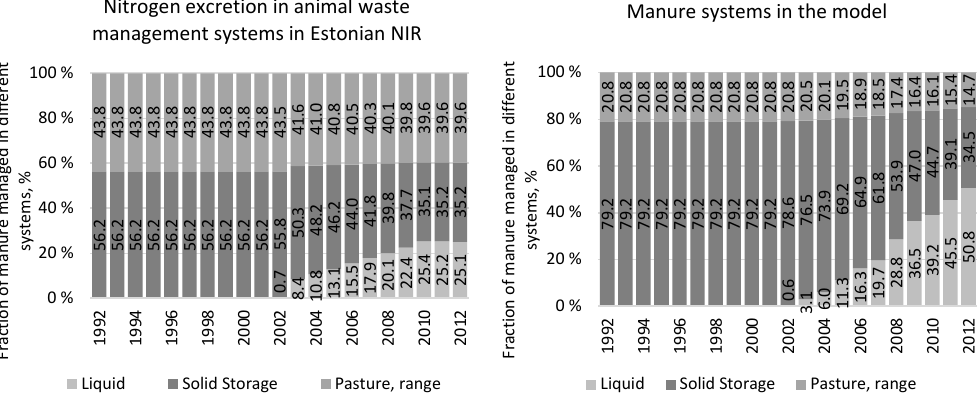
Fig. 4. Manure systems and changes in the structure of manure systems from 1992−2012 in Estonian NIR and in the model (Estonian NIR 2014, MoA 2012, ARIB 2015, ELPR 2015, SE